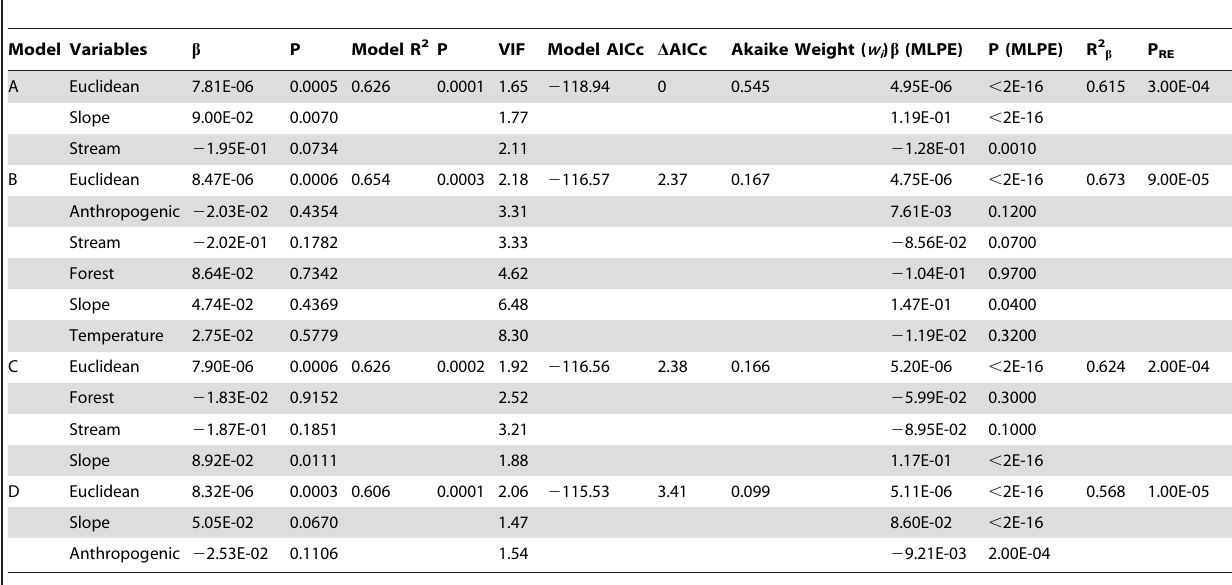
Table 4. Multiple regression on distance matrices (MRM) and maximum likelihood population effects (MLPE) results showing the relationship between pairwise genetic distance (linearized D est ) and resistance distances incorporating landscape